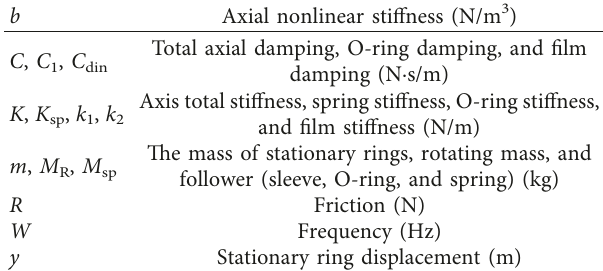
Figure 7: Effect of stiffness on the output spectrum. (a) Nonlinear output spectrum with K � 20000N/m. (b) Relationship between linear stiffness and response peak. Table 1: Symbol